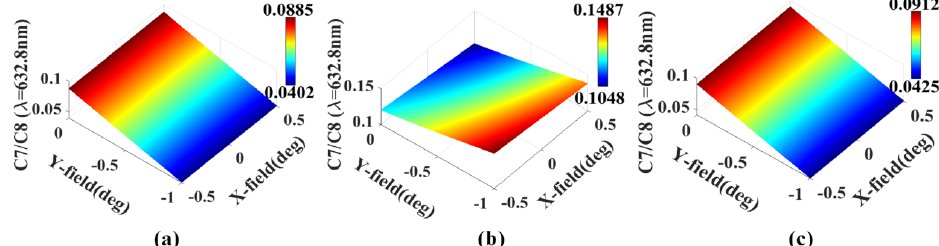
Figure 3. Distribution of Fringe Zernike coma (C7/8) in the full-field of the off-axis TMA telescope: ( a ) before perturbation, ( b ) after perturbation, and ( c ) after compensation correction.